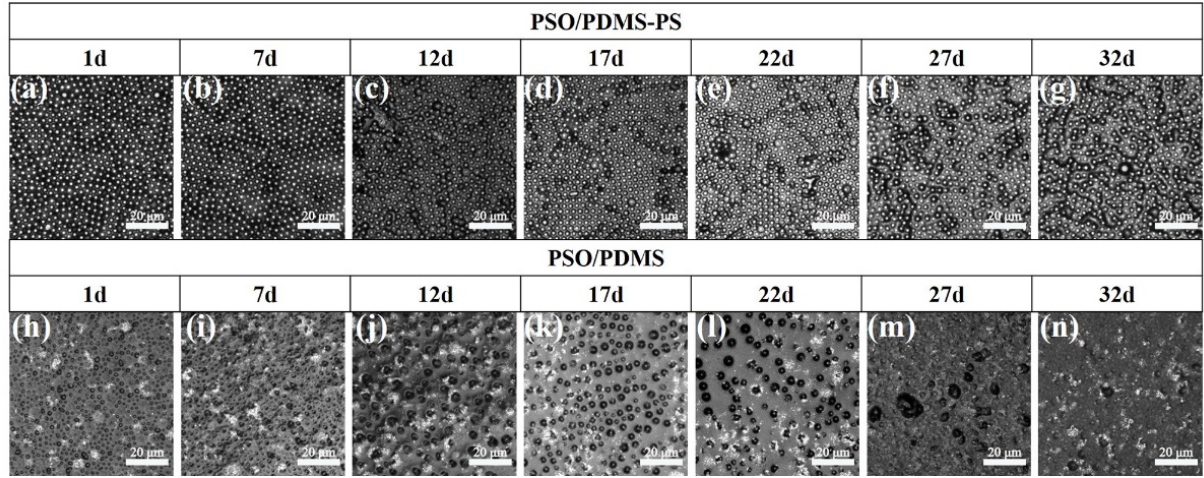
Figure 4. Laser confocal topography of PSO exuded on the surface of PSO/PDMS-PS and PSO/PDMS. ( a , h ): 1 d; ( b , i ): 7 d; ( c , j ): 12 d; ( d , k ): 17 d; ( e , l ): 22 d; ( f , m ): 27 d; ( g , n ): 32 d.